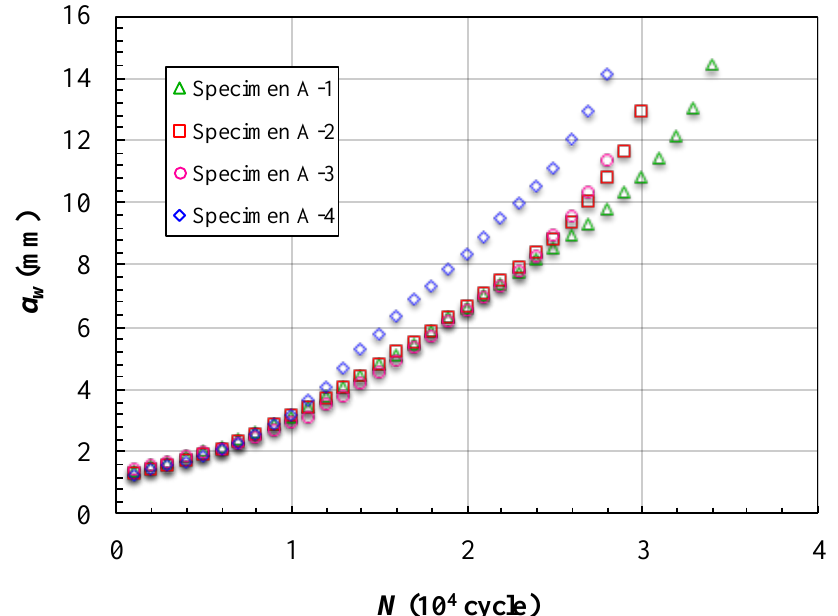
Figure 10. Crack length a w vs loading cycles N of specimens of Group A.